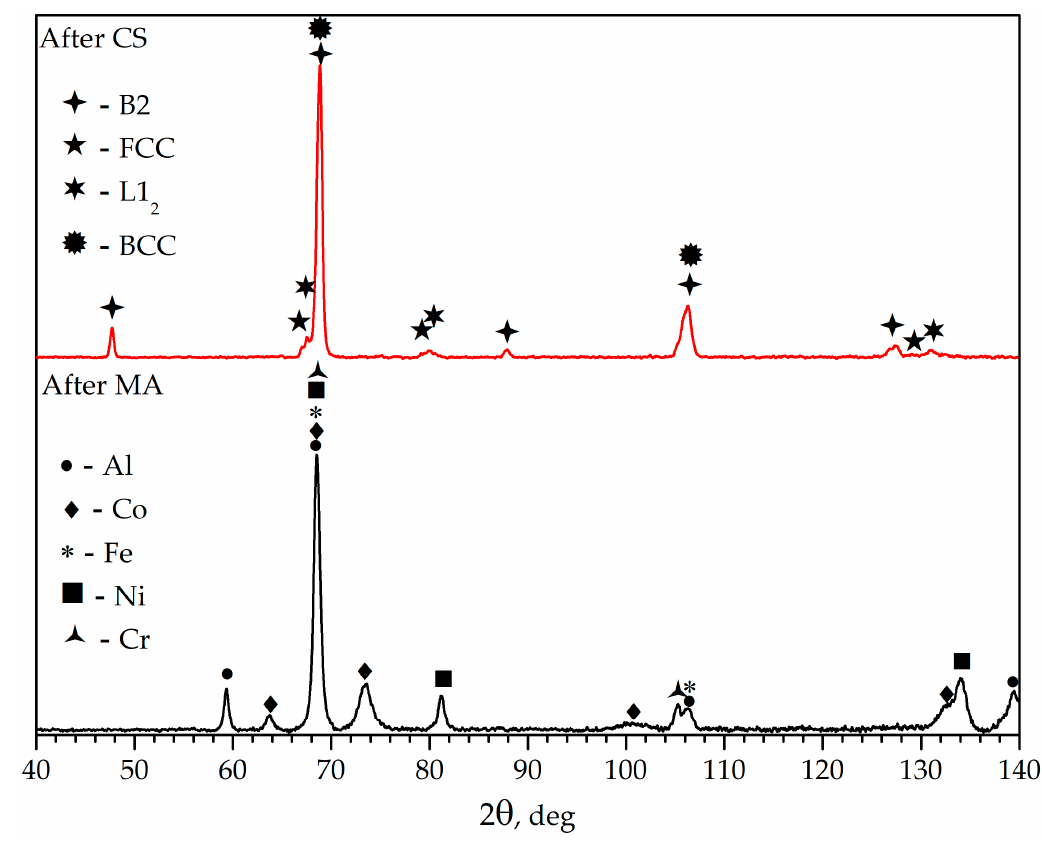
Figure 1. X-ray diffraction data for the MA and CS powders. Table 1. Notation and lattice parameters of the identified phases after CS.